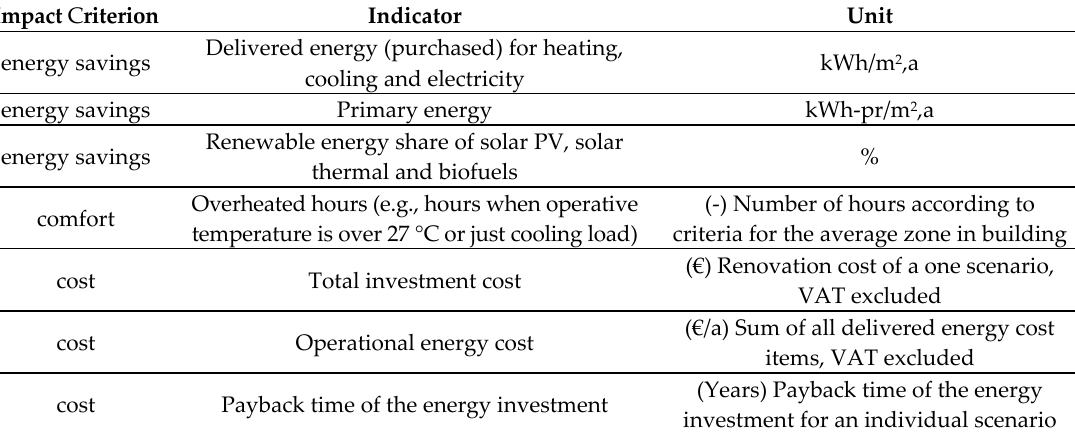
Table 1. The Owners’ Project Requirements (OPRs) in the BIMeaser